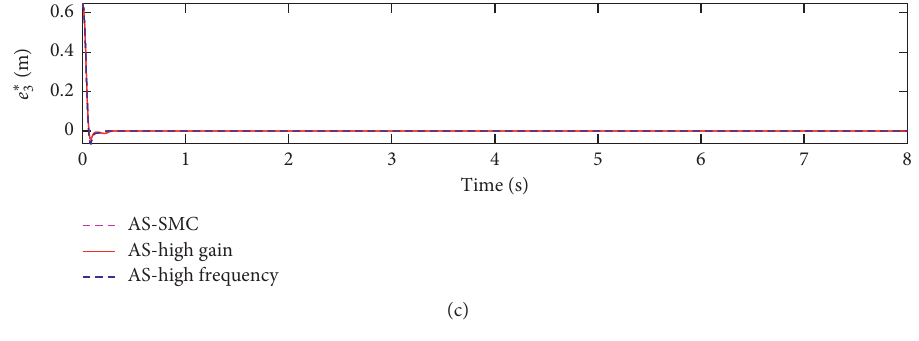
Figure 11: The cross-coupling errors.